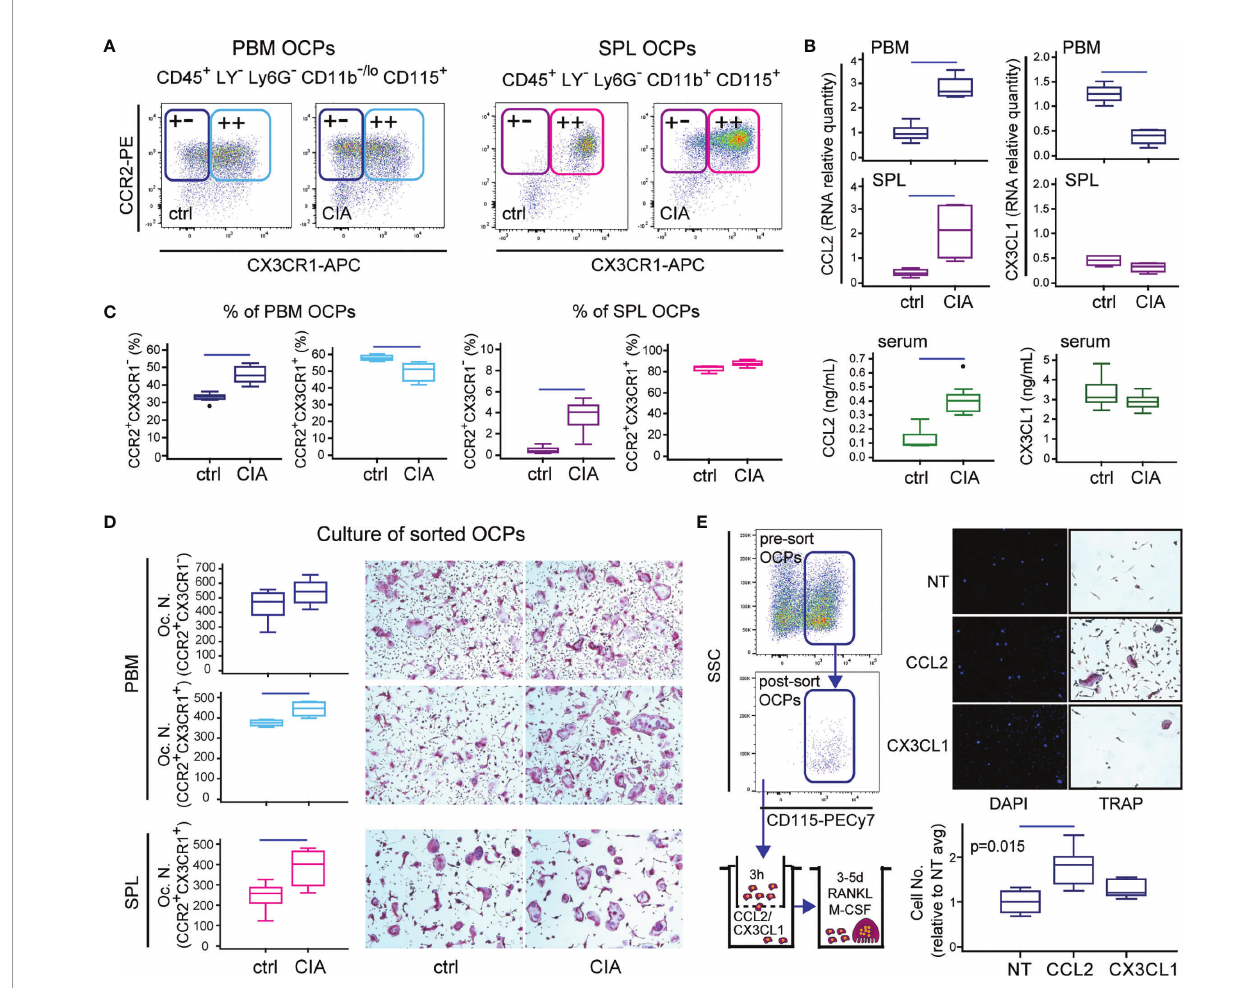
FIGURE 2 | Importance of the CCL2/CCR2 and CX3CL1/CX3CR1 axes in B6 mice with collagen-induced arthritis (CIA). (A) Representative dot plots for fl ow cytometric analysis of CCR2 and CX3CR1 expression on osteoclast progenitors (OCPs) de fi ned as CD45 + CD3 - B220 - NK1.1 - Ly6G - CD11b -/lo CD115 + cells in periarticular bone marrow (PBM) and CD45 + CD3 - B220 - NK1.1 - Ly6G - CD11b + CD115 + cells in spleen (SPL) of control (ctrl) and CIA mice. (B) qPCR analysis of chemokine gene expression levels in PBM and SPL presented as relative quantity of RNA, and serum levels of chemokine ligands measured by enzyme-linked immunosorbent assay (ELISA), in ctrl and CIA mice. (C) Proportion of single-positive (CCR2 + CX3CR1 - ) and double-positive (CCR2 + CX3CR1 + ) OCPs in PBM and SPL of ctrl and CIA mice. (D) Osteoclastogenic potential of single-positive (PBM CCR2 + CX3CR1 - ) and double-positive (PBM and SPL CCR2 + CX3CR1 + ) OCPs of ctrl and CIA mice. Sorted cells were plated and stimulated by receptor activator of nuclear factor k B ligand (RANKL) and macrophage colony-stimulating factor (M-CSF). Differentiated tartrate-resistant acid phosphatase (TRAP) + multinucleated osteoclast-like cells were counted per well (Oc.N.). Representative microphotographs of in vitro differentiated TRAP + osteoclast-like cells are presented (magni fi cation 100×). (E) In vitro migration assay of sorted PBM OCPs of arthritic mice (CIA) using Transwell system. Cells migrated to the bottom membrane of the insert were stained with 4 ’ ,6-diamidino-2-phenylindole (DAPI), counted ( n = 2 wells per group; 7 fi elds per well), and normalized to the average value of non-treated group (NT avg). Cells that migrated to the lower chamber were cultured with RANKL and M-CSF. Representative images of NT, CCL2- and CX3CL1-attracted cells (nuclei stained with DAPI) and in vitro differentiated TRAP + osteoclast-like cells are presented (magni fi cation 100×). The experiments were repeated three times and pooled data are shown ( n = 6 – 10 mice per group). Values are presented as medians (middle horizontal lines), boxes represent the interquartile range (IQR), whiskers represent 1.5 times the IQR, and outliers are represented by circles. Statistically signi fi cant difference was determined at p < 0.05, Mann – Whitney U -test (B – D) or Kruskal – Wallis test ( p -value marked on the graph) with Conover post-hoc test for group-to- group comparisons (E) ; correction for multiple comparisons (B) was performed using Holm – Bonferroni method; line denotes signi fi cant difference between groups. LY —